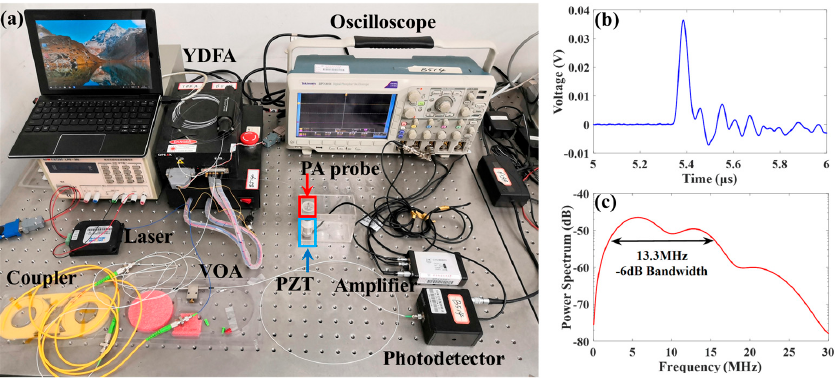
Figure 2. ( a ) Picture of experimental setup. Measured ( b ) time- and ( c ) frequency-domain PA pulse response of the developed transducer. response of the developed